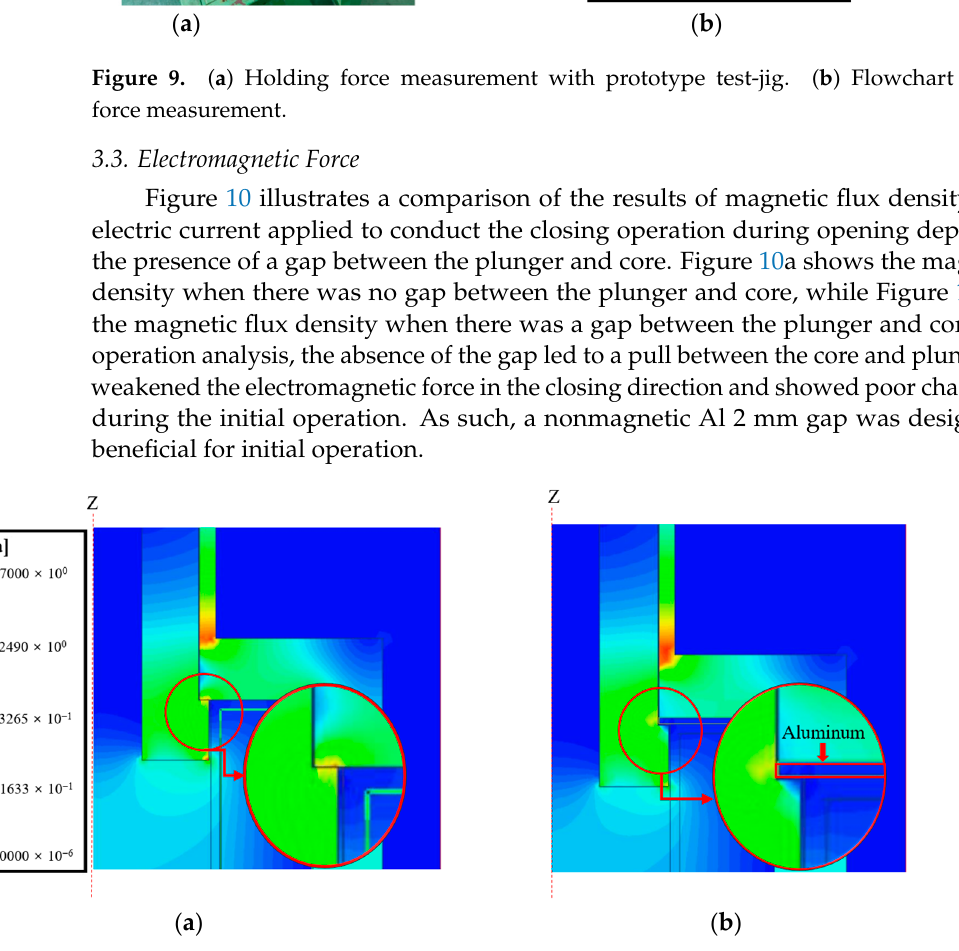
Figure 10. The magnetic flux density of the current applied in the open state ( a ) without and ( b ) with a gap.